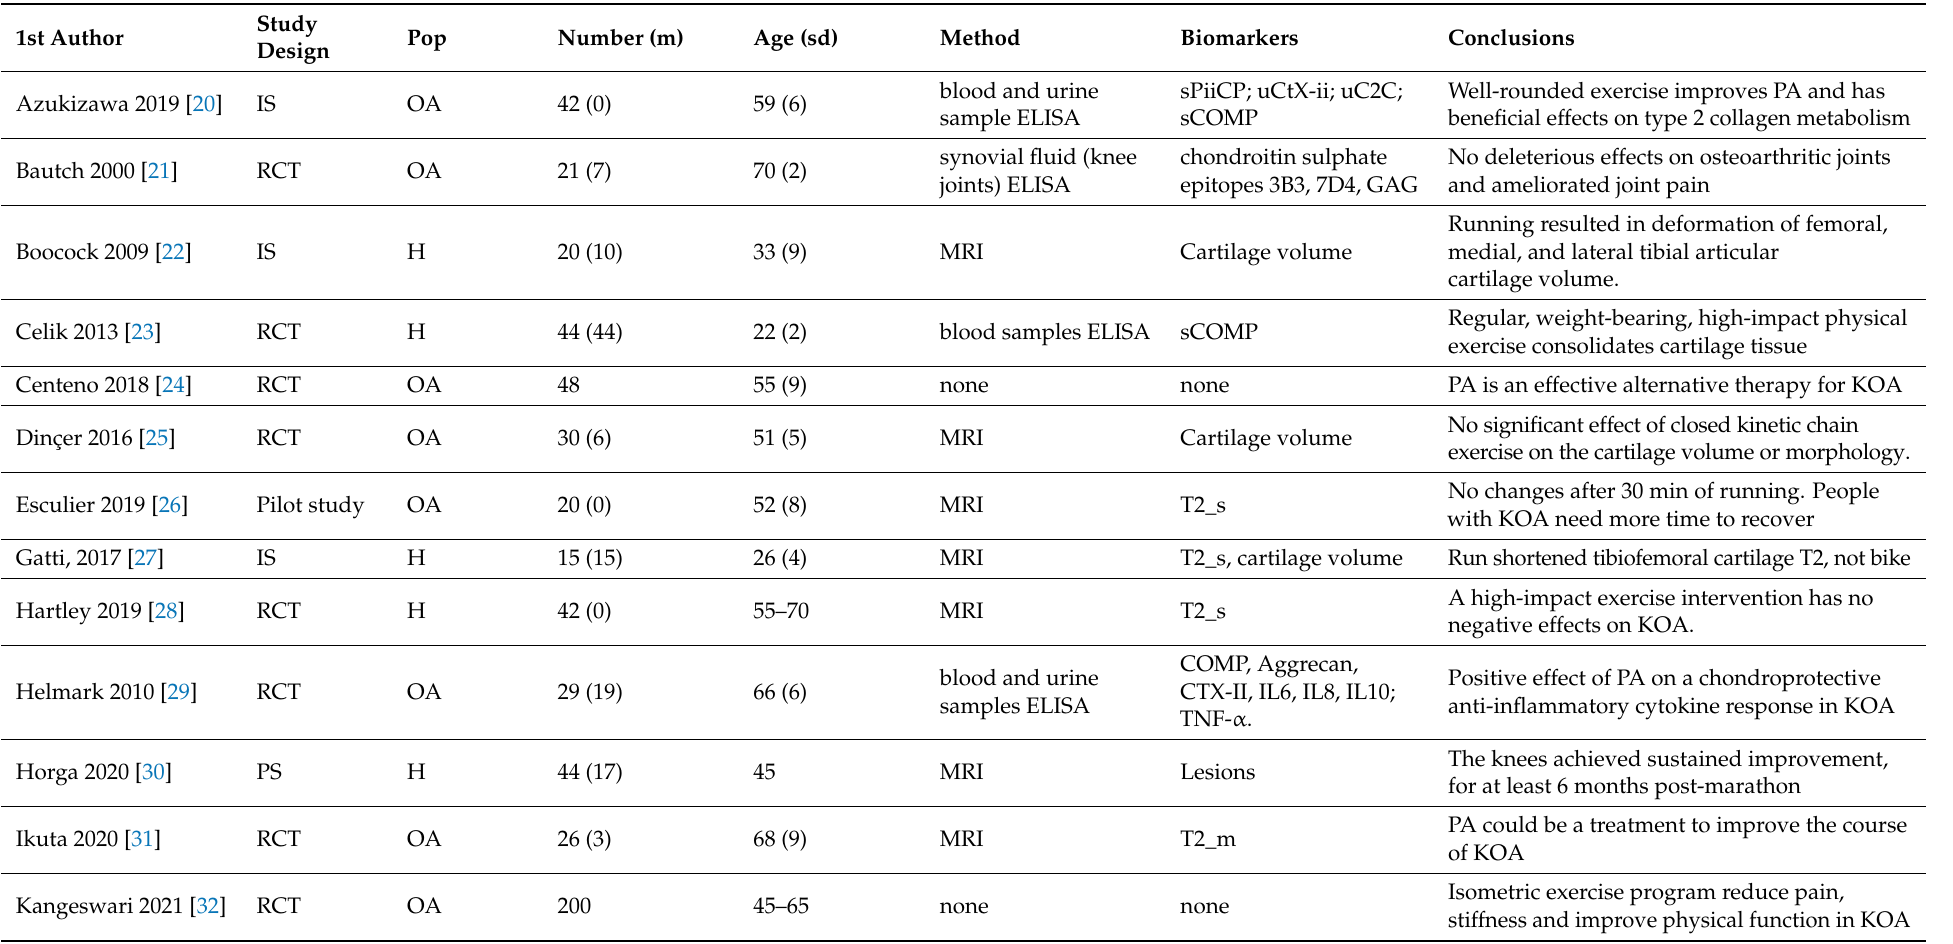
Table 1. Overview of the studies